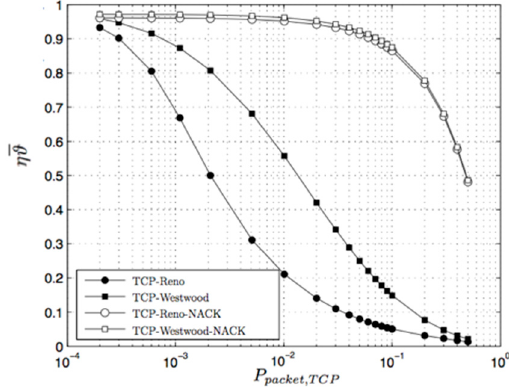
Figure 8. Theoretical ηϑ as a function of the error packet probability. Figure 8. Theoretical η (cid:2036)̅ as a function of the error packet probability. Figure 8. Theoretical η (cid:2036)̅ as a function of the error packet probability.